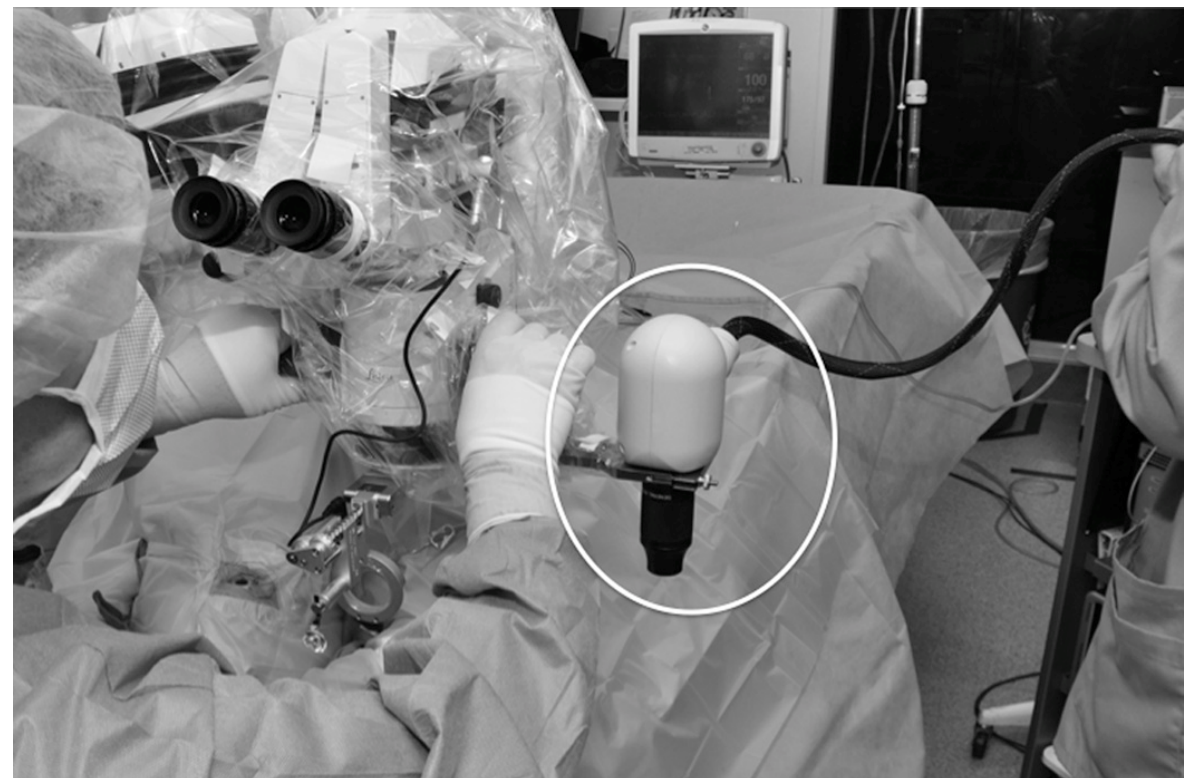
Figure 8. Intraoperative OCT with portable mounted microscope (circled) by Ehlers et al. [115]. Reprinted with permission from Ehlers et al. The Prospective Intraoperative and Perioperative Ophthalmic ImagiNg with Optical CoherEncE TomogRaphy (PIONEER) Study: 2-year results. Am J Ophthalmol.. 2014 Nov;158(5):999-1007 with license permissions obtained from Elsevier and Copyright Clearance Center.